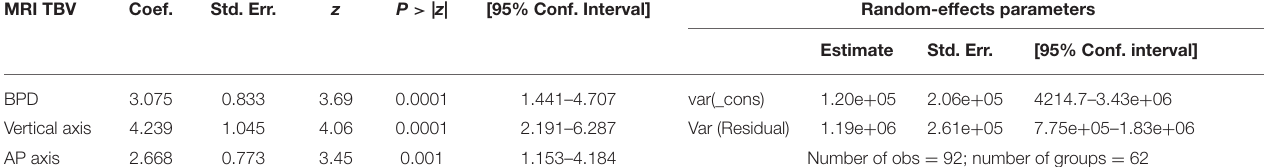
TABLE 7 | Parameters of MRI TBV prediction mixed effect model by three orthogonal axes (BPD, anteroposterior, and vertical axis). MRI TBV Coef. Std. Err.